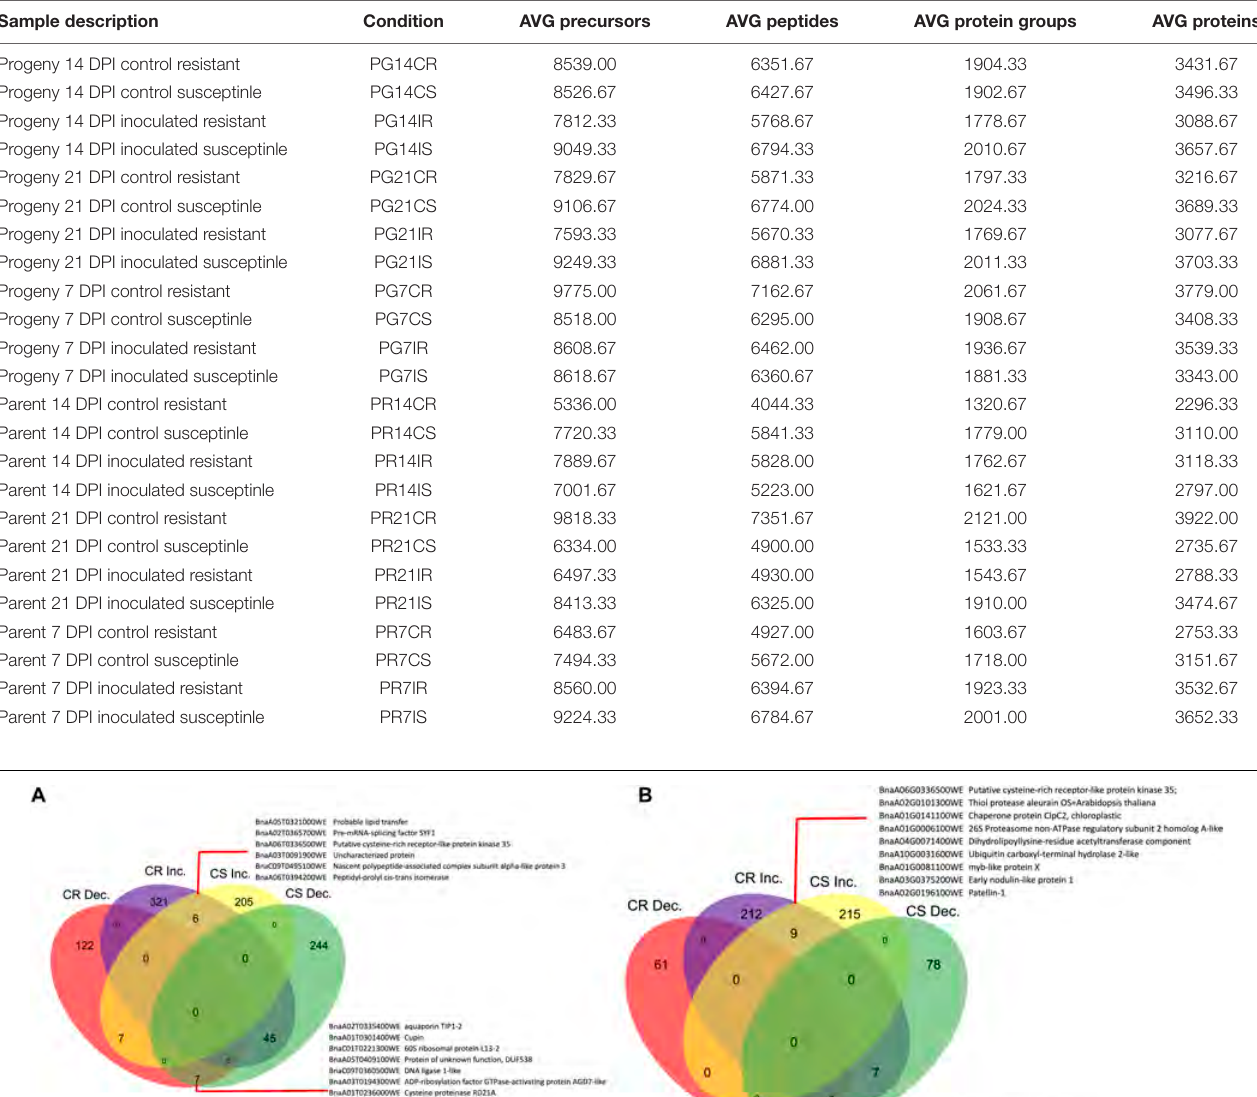
TABLE 1 | Sample description and protein run information.